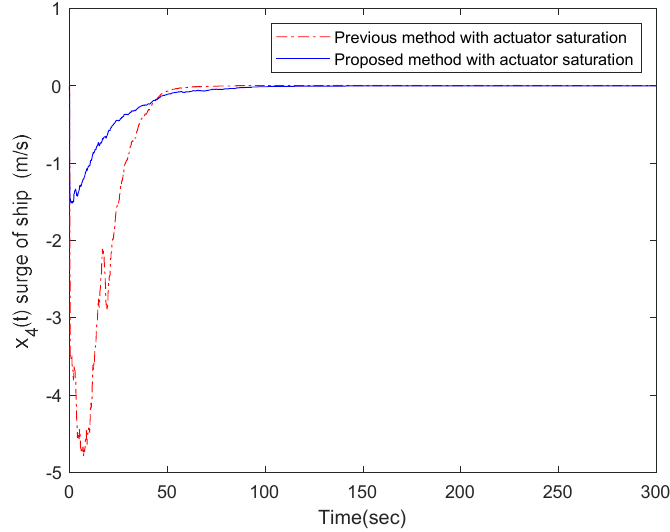
Figure 7. The responses of x ( t ) compared with [29].